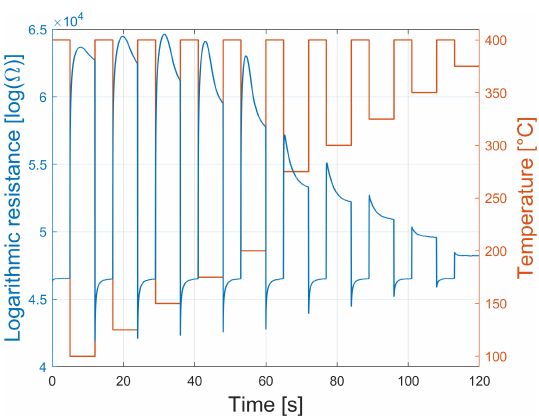
Figure 2. Logarithmic conductance of one sensor element (blue) and the temperature-cycled operation of the SGP30 (red).